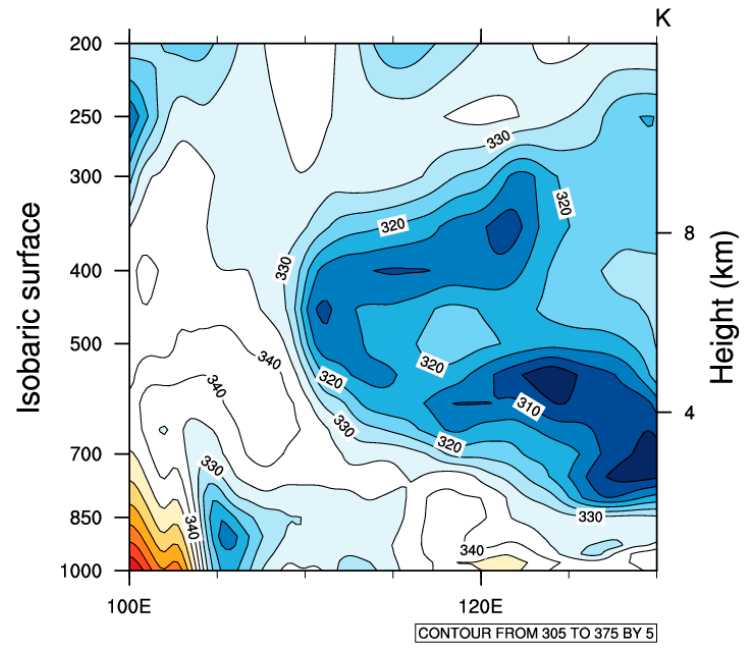
Figure 7. Longitude-vertical cross section of pseudo equivalent potential temperature (K) along 32°N at 0000 UTC 16 September 2018.